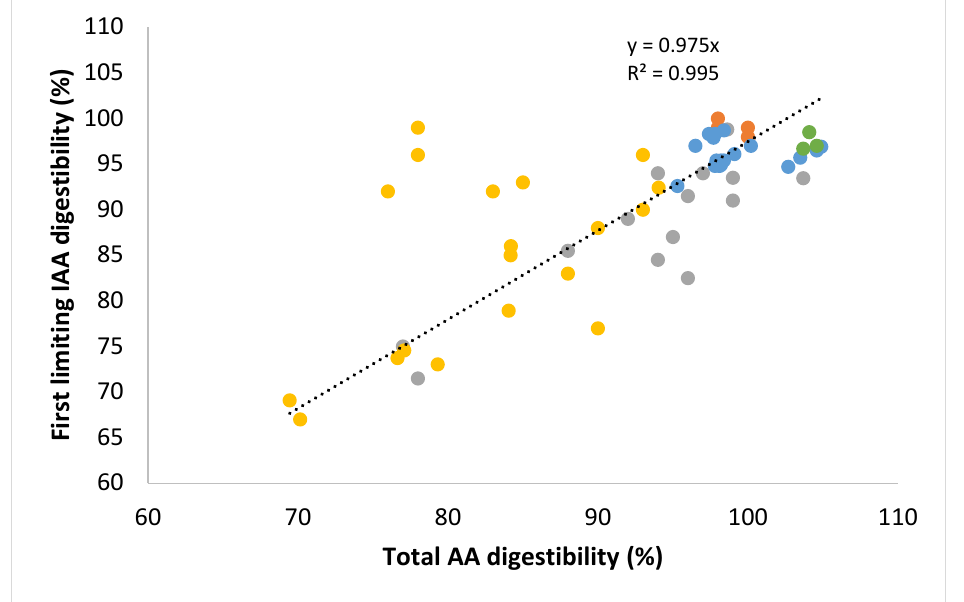
Figure 6. Relation between ileal digestibility of total amino acids (AA) and of the first limiting in- dispensable amino acid (IAA) histidine ( ) , sulphur-containing amino acids ( ) , lysine ( ) , valine ( ) or leucine ( ) of different food sources. Data from studies in pigs [57,76–80], and rats [72,81].